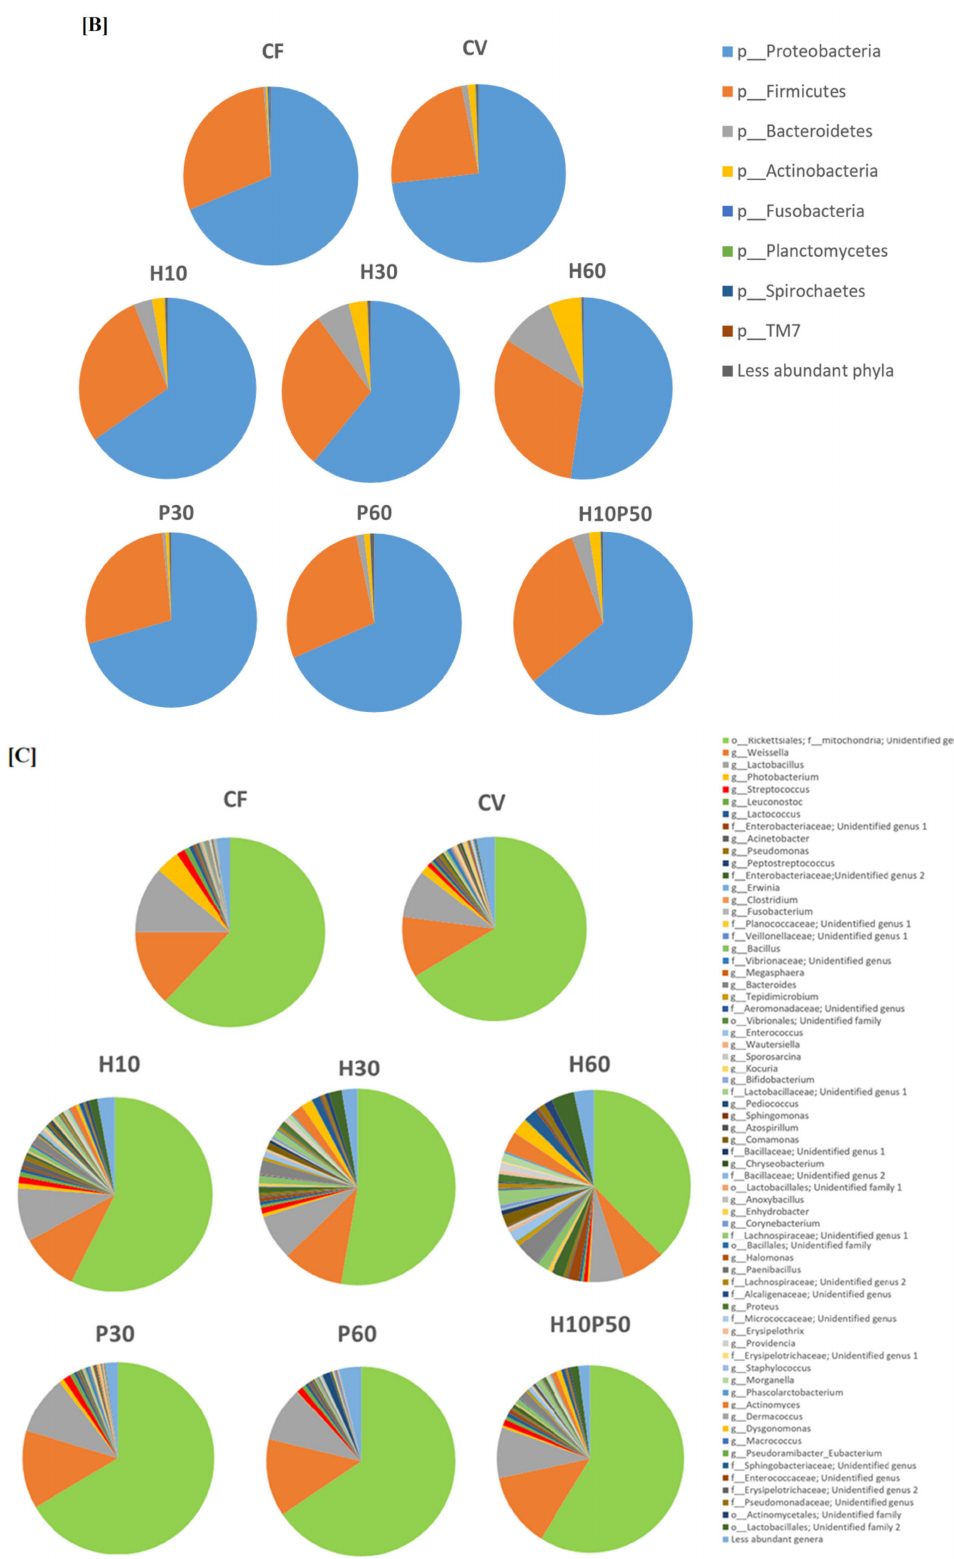
Figure 3. ( A ) PCoA representing the β -diversity of microbial populations in fish feed, according to Bray–Curtis dissimilarity ( p < 0.001). Percentage relative abundance of phyla ( B ) and genera ( C ) in fish feed. Unassigned phyla or genera include those with percentage sequence homology less than 95% with the Greengenes database. Less abundant phyla or genera include bacteria with a relative abundance less than 0.01% in fewer than 25% of